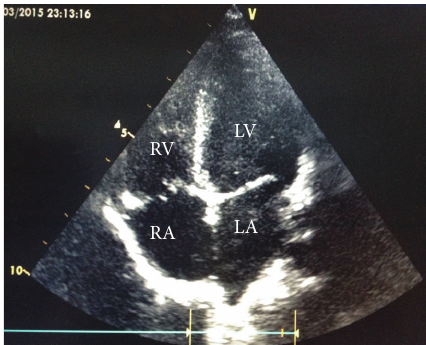
Figure 3: A 4-chamber view showing normal right atrium (RA), normal right ventricle (RV), normal left atrium (LA), and normal left ventricle (LV) 6 months after